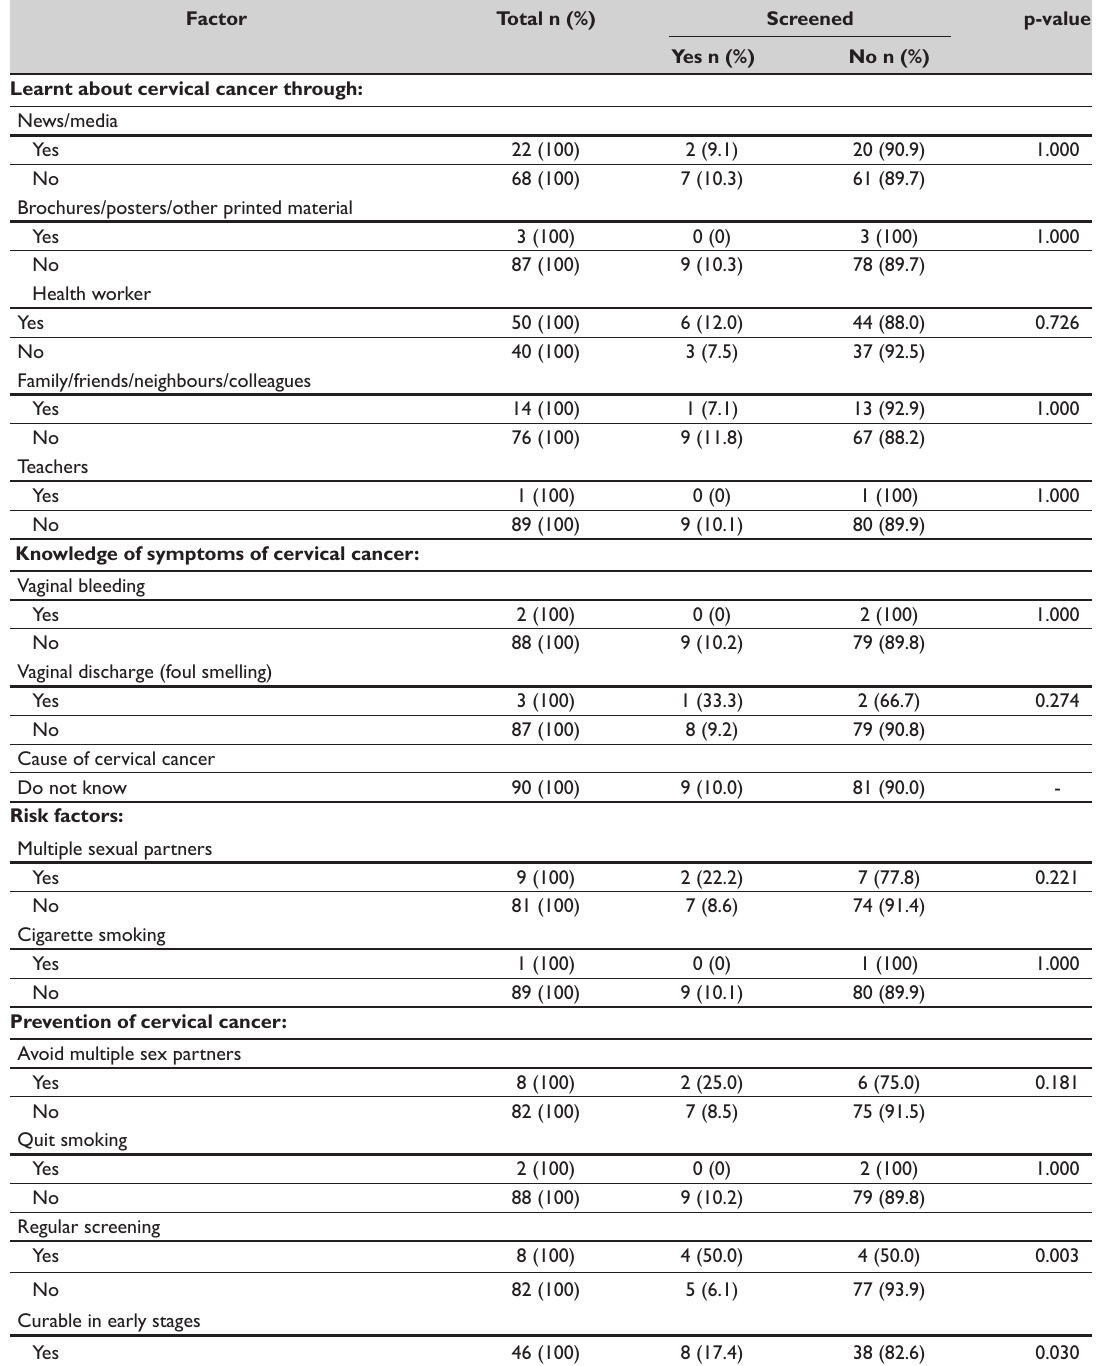
Table 3: Knowledge on cervical cancer associated with cervical cancer